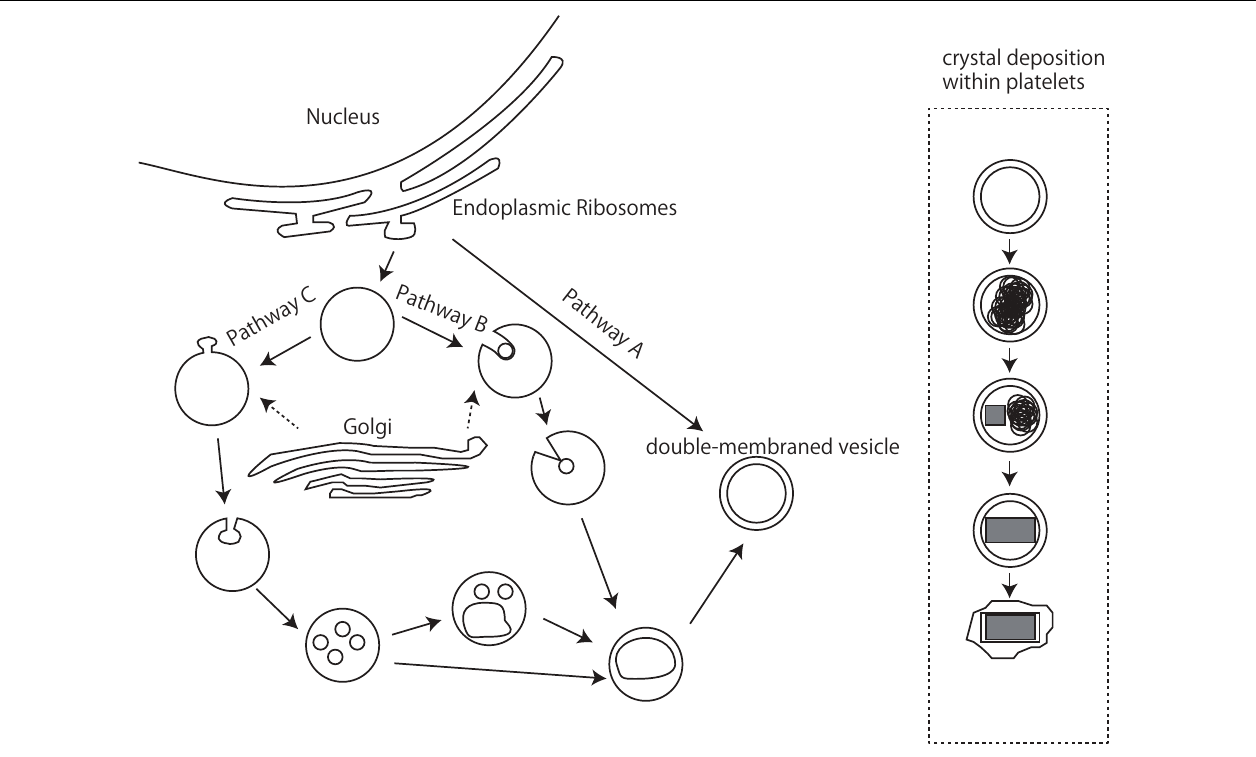
FIGURE 6 | A schematic drawing of iridophore organellogenesis by Morrison and Frost-Mason, 1991. Three pathways of origin of the primordial double membraned vesicles and crystal deposition.